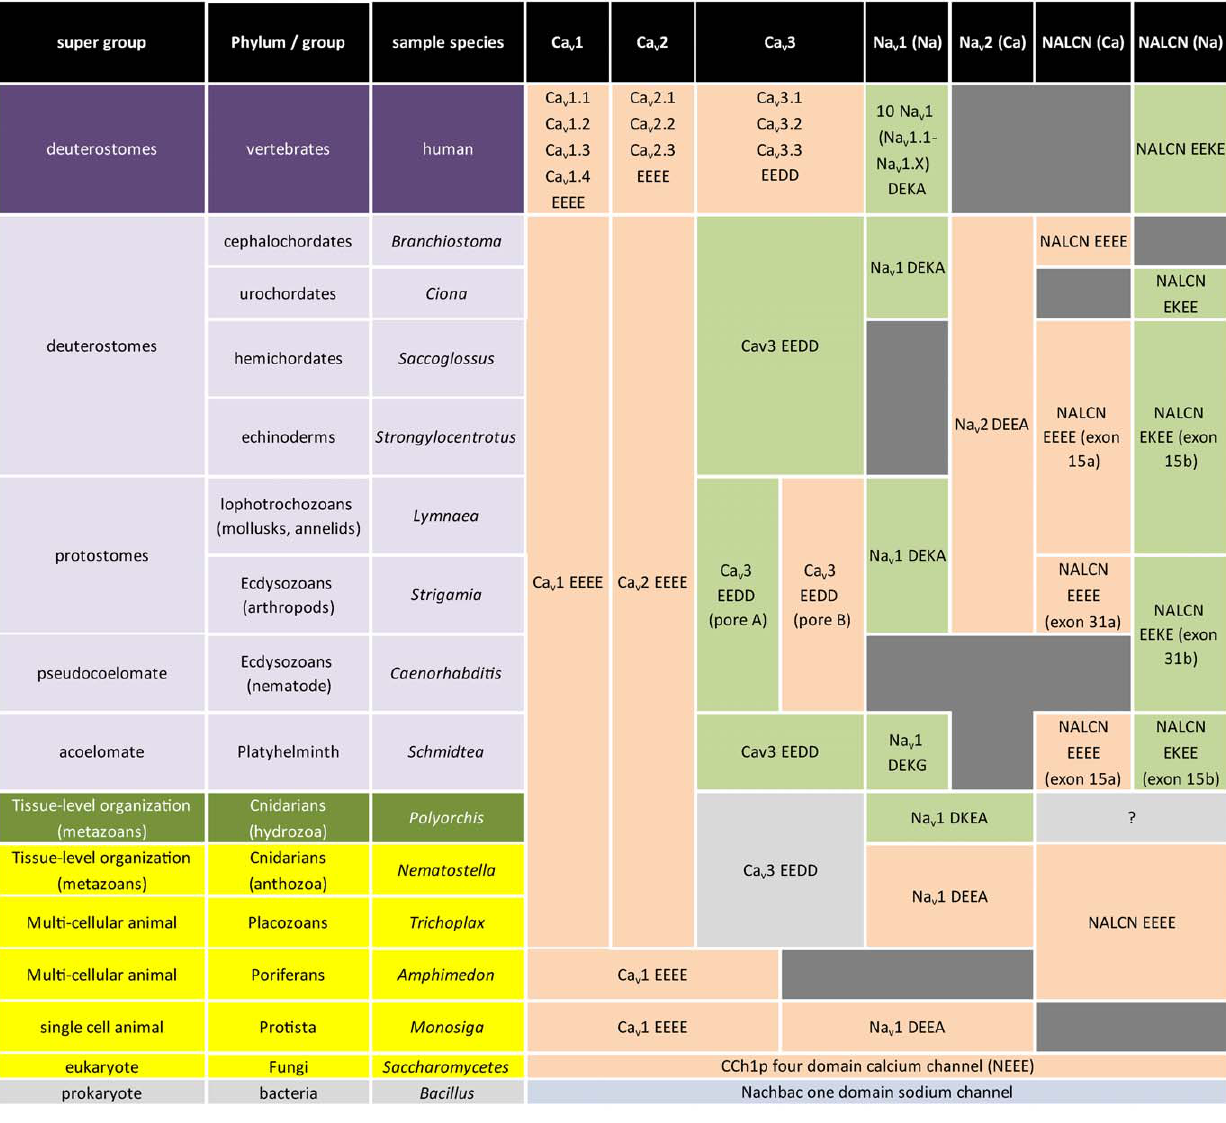
Figure 9. Conservation patterns suggest greater flexibility in calcium and sodium selectivity in 4-domain cation channels before vertebrate evolution. All 4-domain cation channels first existed with calcium-selective pores (i.e. Ca v (EEEE), Na v (DEEA) and NALCN (EEEE)).